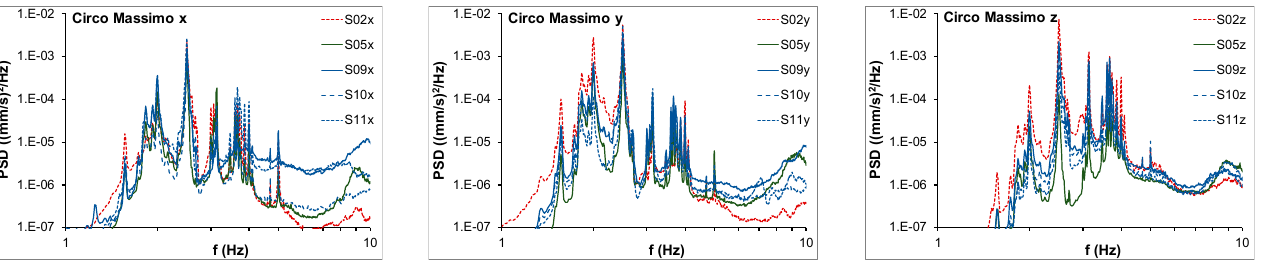
Figure 6. PSDs of the recordings on the Moletta Tower for the entire time length.